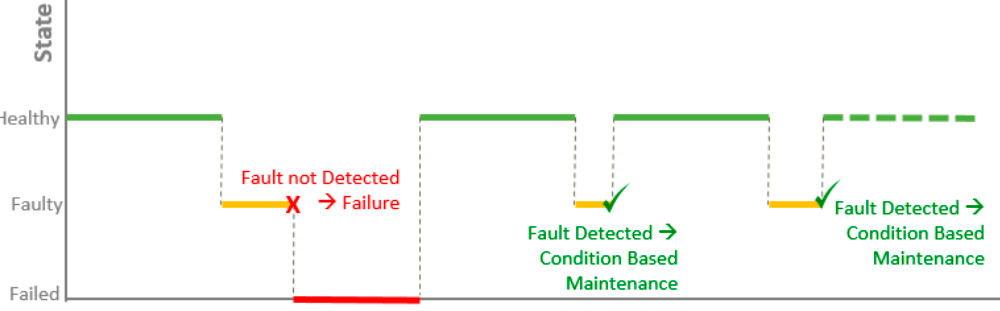
Figure 2. State of a component with undetected faults (leading to failure) and detected faults (leading to condition based maintenance).